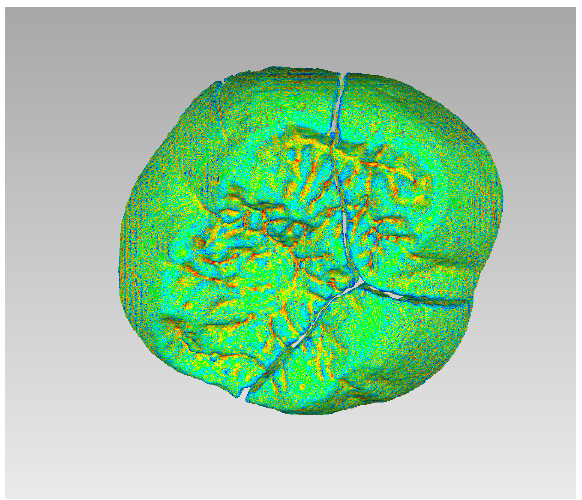
Figure 7. Detected crack borders (marked by blue color in the tooth 3D model)